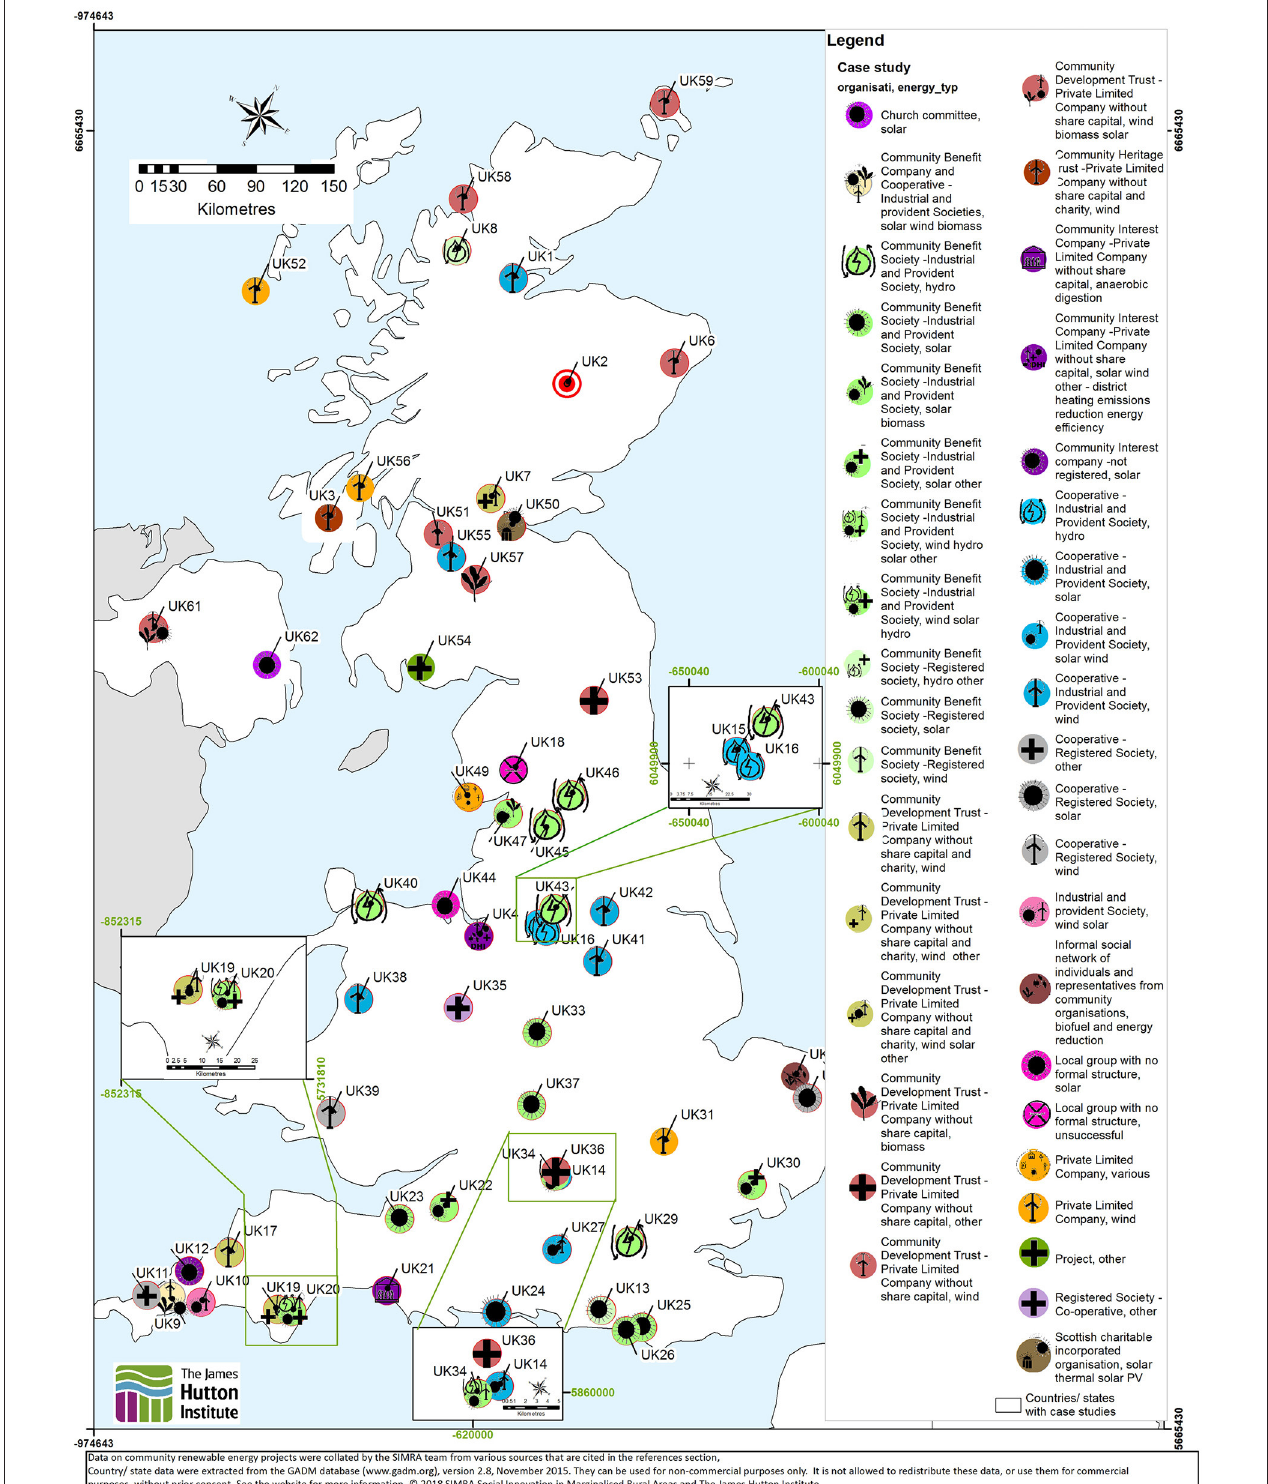
FIGURE 9 | CE in the